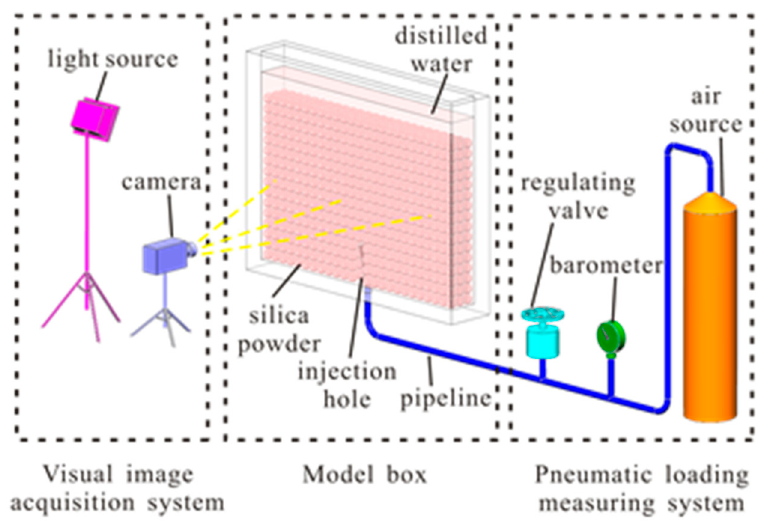
Figure 4. Schematic diagram of the test procedure for shallow gas invasion in fine-grained marine sediments.